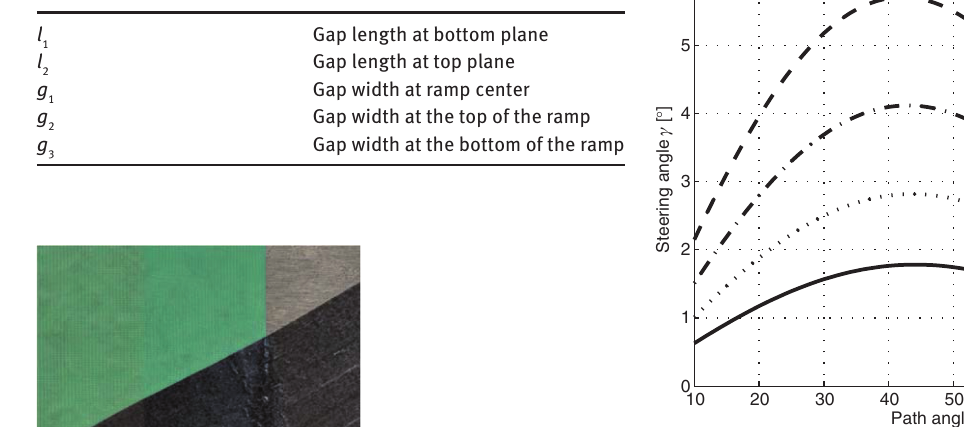
Table 4 Testing of gaps: evaluated test results.